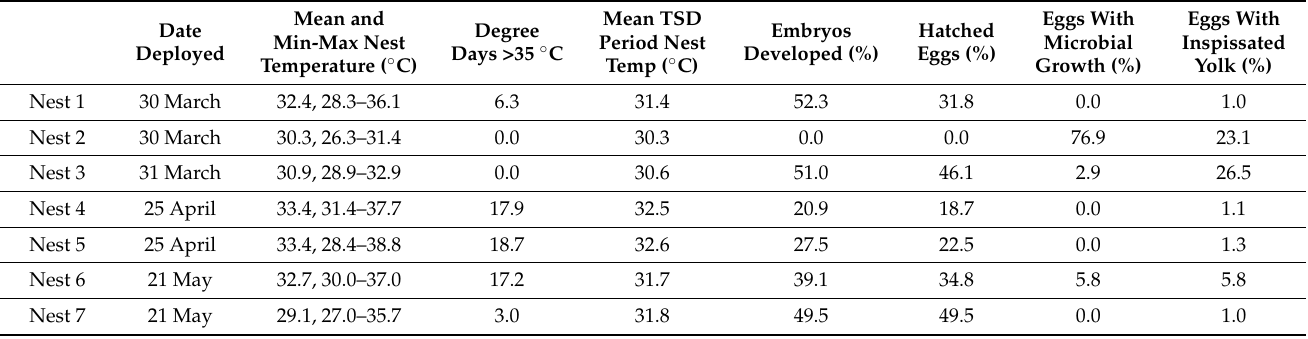
Table 2. Mean and range of nest temperatures and calculated degree days and associated variables in seven leatherback sea turtle ( Dermochelys coriacea ) nests during the 2019 nesting season at Levera Beach, Grenada. Temperature loggers were deployed for 60–80 days during nest